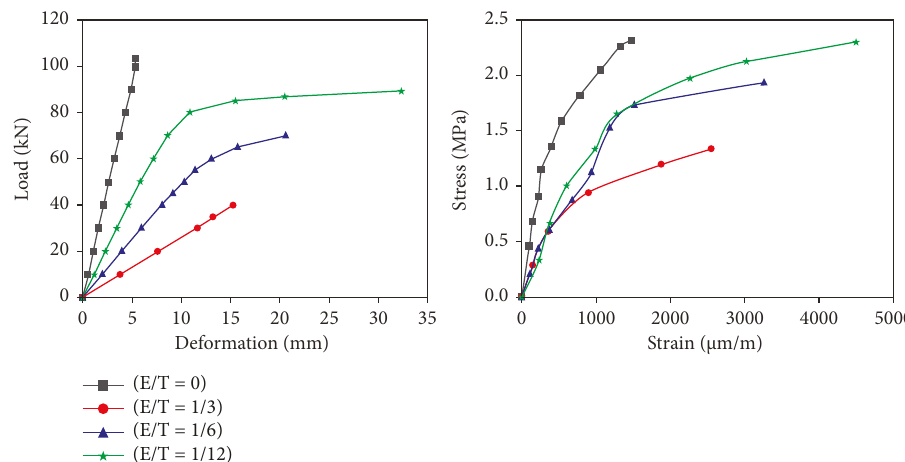
Figure 4: Load-deformation curve and stress-strain curves at the centre for CSRE specimens with H/T � 3.